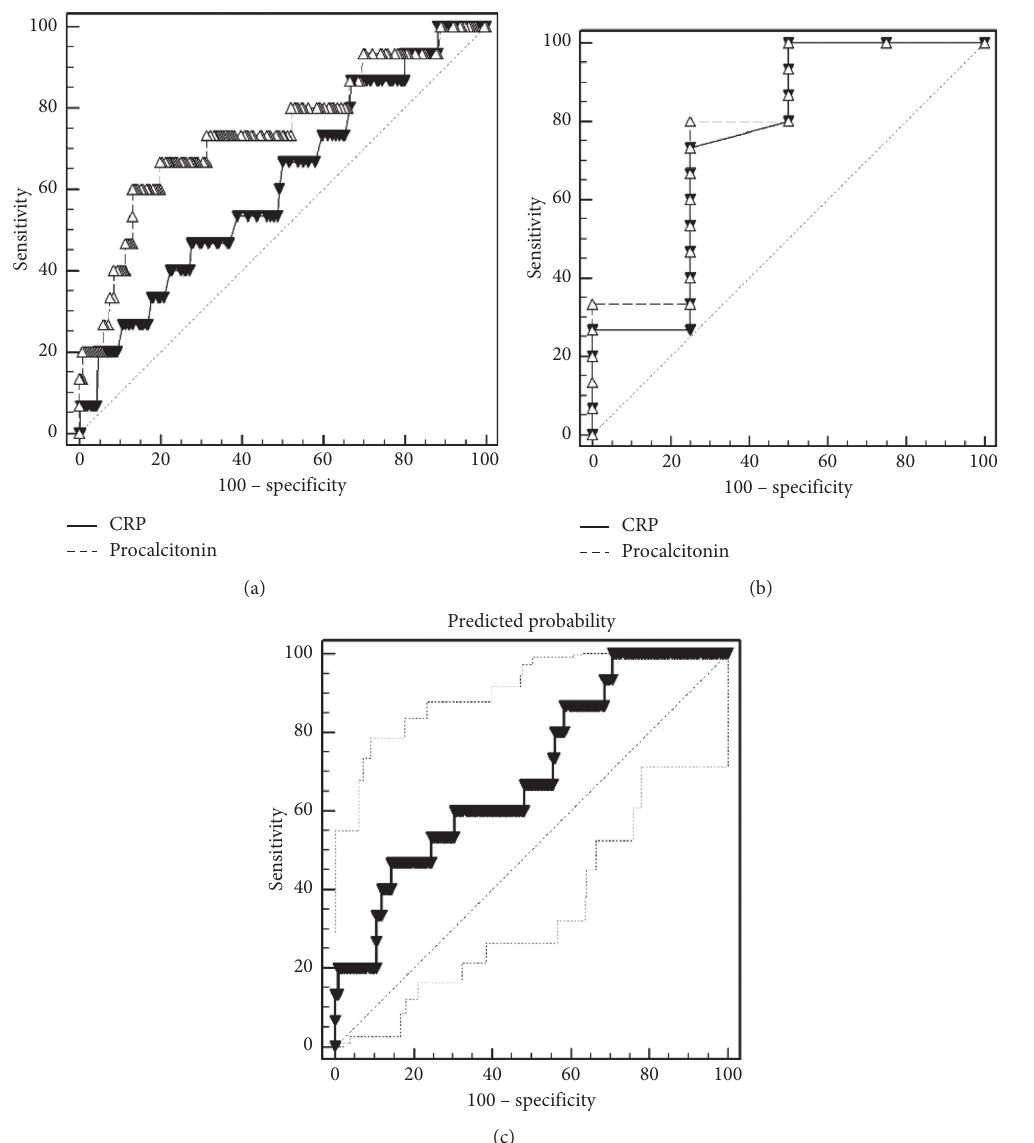
Figure 1: ROC curve of PCT and CRP in diagnosing bloodstream infections in oncology patients (a) between bacteremia and non- bacteremia groups, (b) between bacteremia and contamination groups, and (c) combined PCT and CRP between bacteremia and non- bacteremia